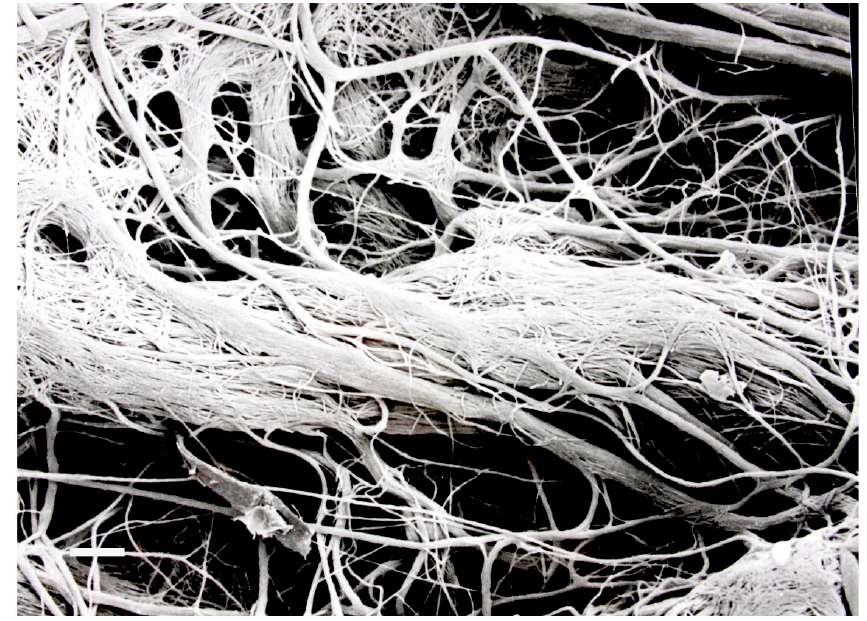
Figure 2. The convoluted and interwoven hyphae of Muscodor albus , a volatile antibiotic producing fungus. The white bar is equivalent to 5 microns.